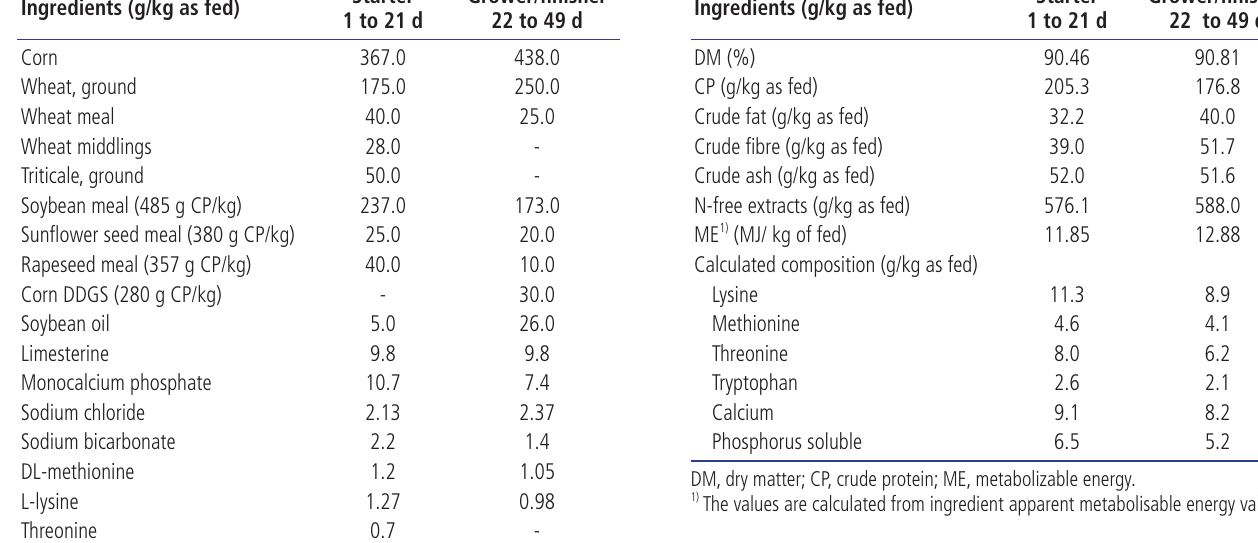
Table 1. Ingredients of the diets for ducks Ingredients (g/kg as fed)